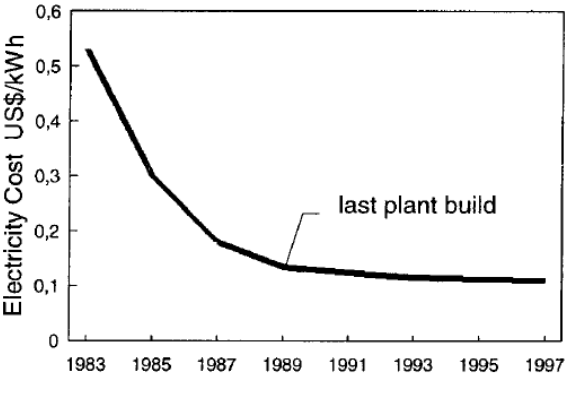
Figure 69. Learning curve for Concentrating Solar Power. © 2000 Elsevier, reproduced with permission from